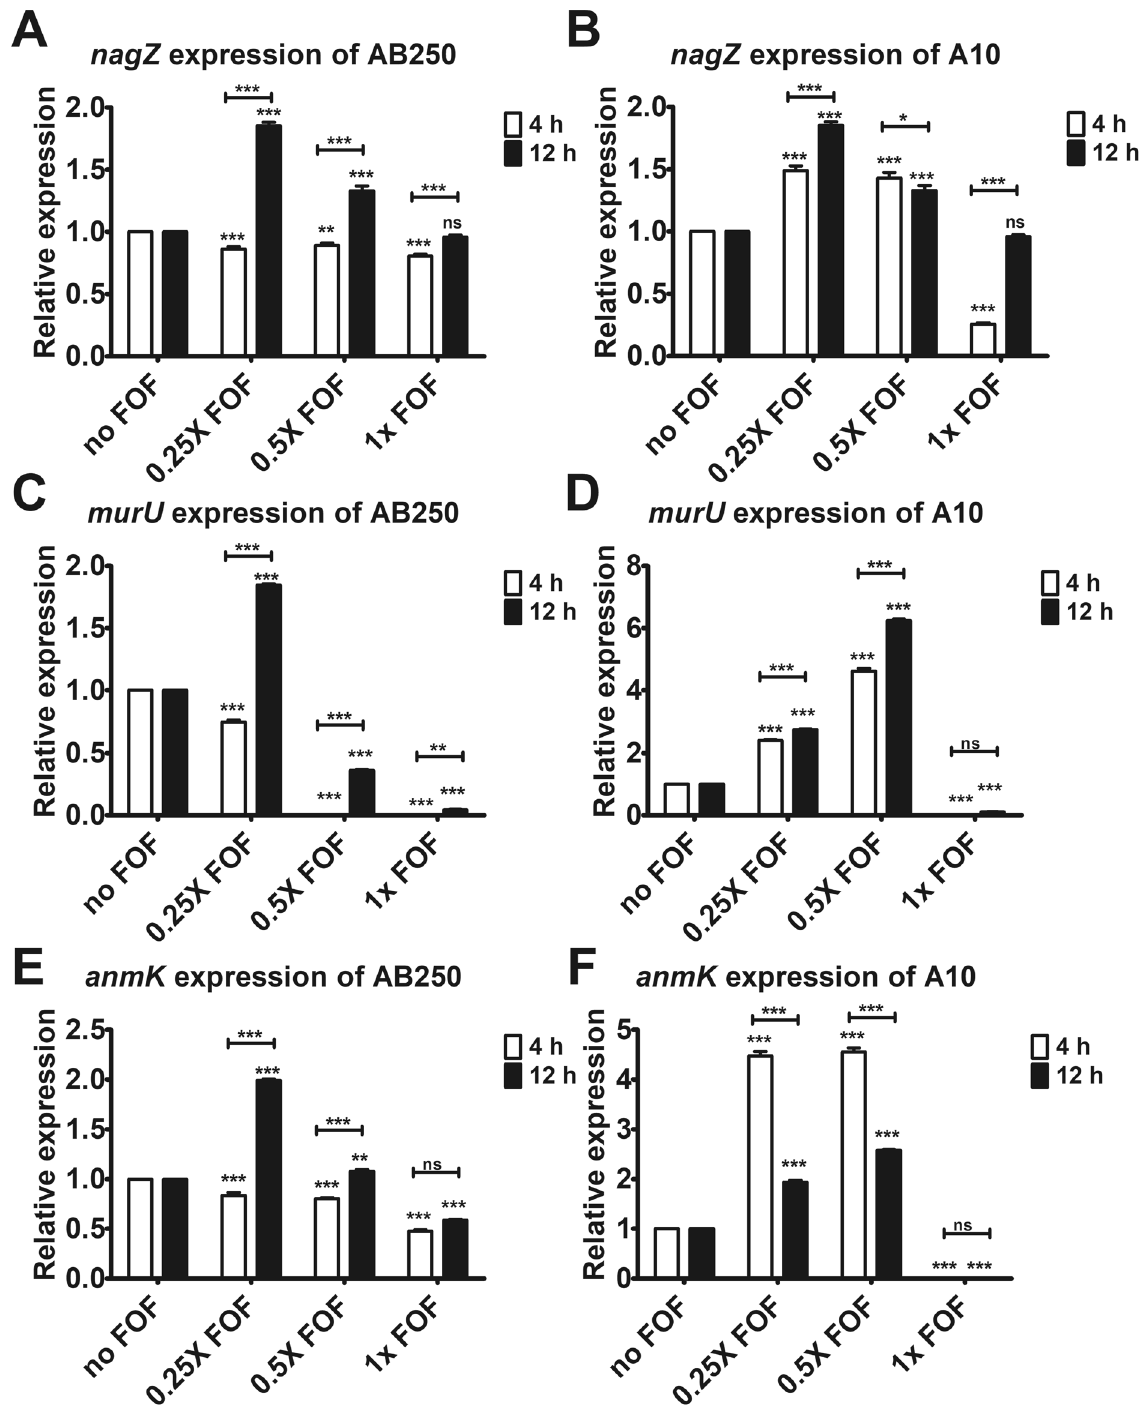
Figure 5. Relative mRNA expression of nagZ , murU , and anmK in the presence of fosfomycin for 4 and 12 h determined by RT-PCR assay in A. baumannii AB250 ( A , C , E ) and A10 ( B , D , F ). The relative mRNA expressions at each condition (in the presence of 0.25× MIC, 0.5× MIC, or 1× MIC of fosfomycin) were normalized to 16S rRNA expression and compared to the mRNA expression level of each isolate in the absence of fosfomycin. All experiments were performed in triplicate. Mean values of the relative mRNA expression were plotted with error bars representing the standard error of the mean (n = 3). The p -values were calculated using one-way ANOVA, Dunnett’s multiple comparison test (* p -value ˂ 0.05; ** p -value < 0.01; *** p -value < 0.001 and ns,